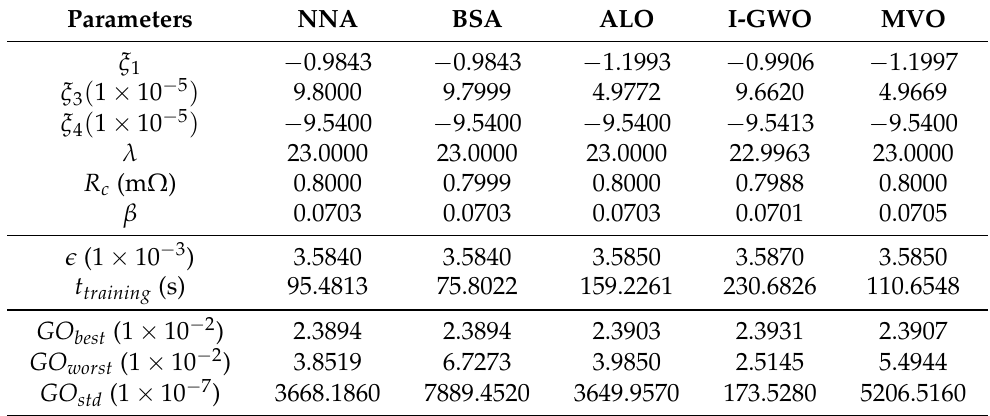
Table 9. Unknown parameters computed and performance information for the modeled polarization curve at 100%